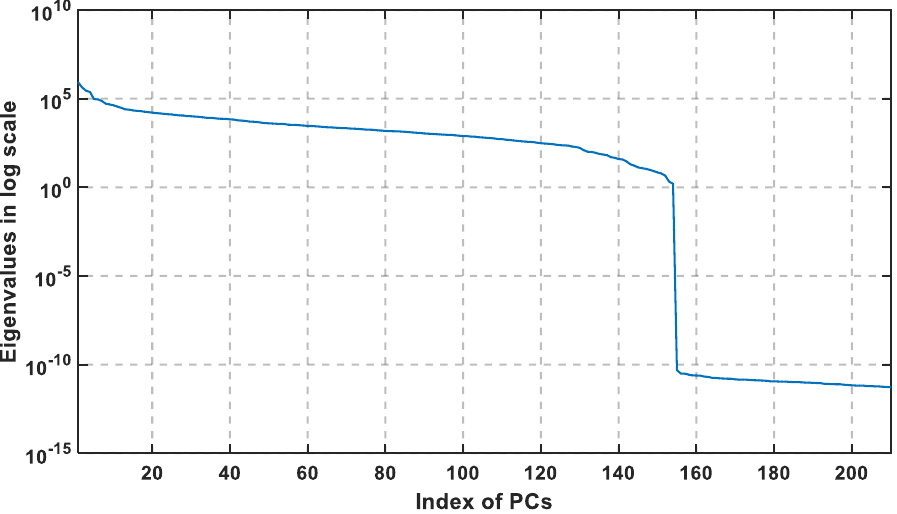
Figure 3. First 210 Eigenvalues (Log Scaled) of Large-Scale Experiment.